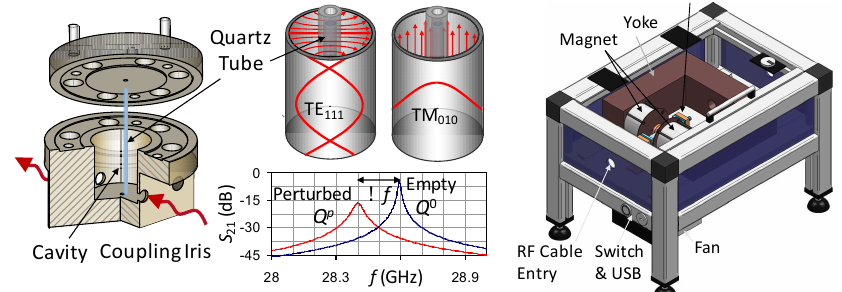
Figure 7. Resonator cavity with coupling iris, where the empty or LC-filled quartz tube is placed in the center ( left ). A dual-mode resonator is shown for both TE 111 and TM 010 mode to measure the LC characteristics parallel and perpendicular to the Radio Frequency (RF) field in a single step only ( middle ), where an example of S 21 measurements for empty and filled tubes is illustrated below. An industrial-scale temperature-controlled LC-characterization setup with permanent magnets ( right ).